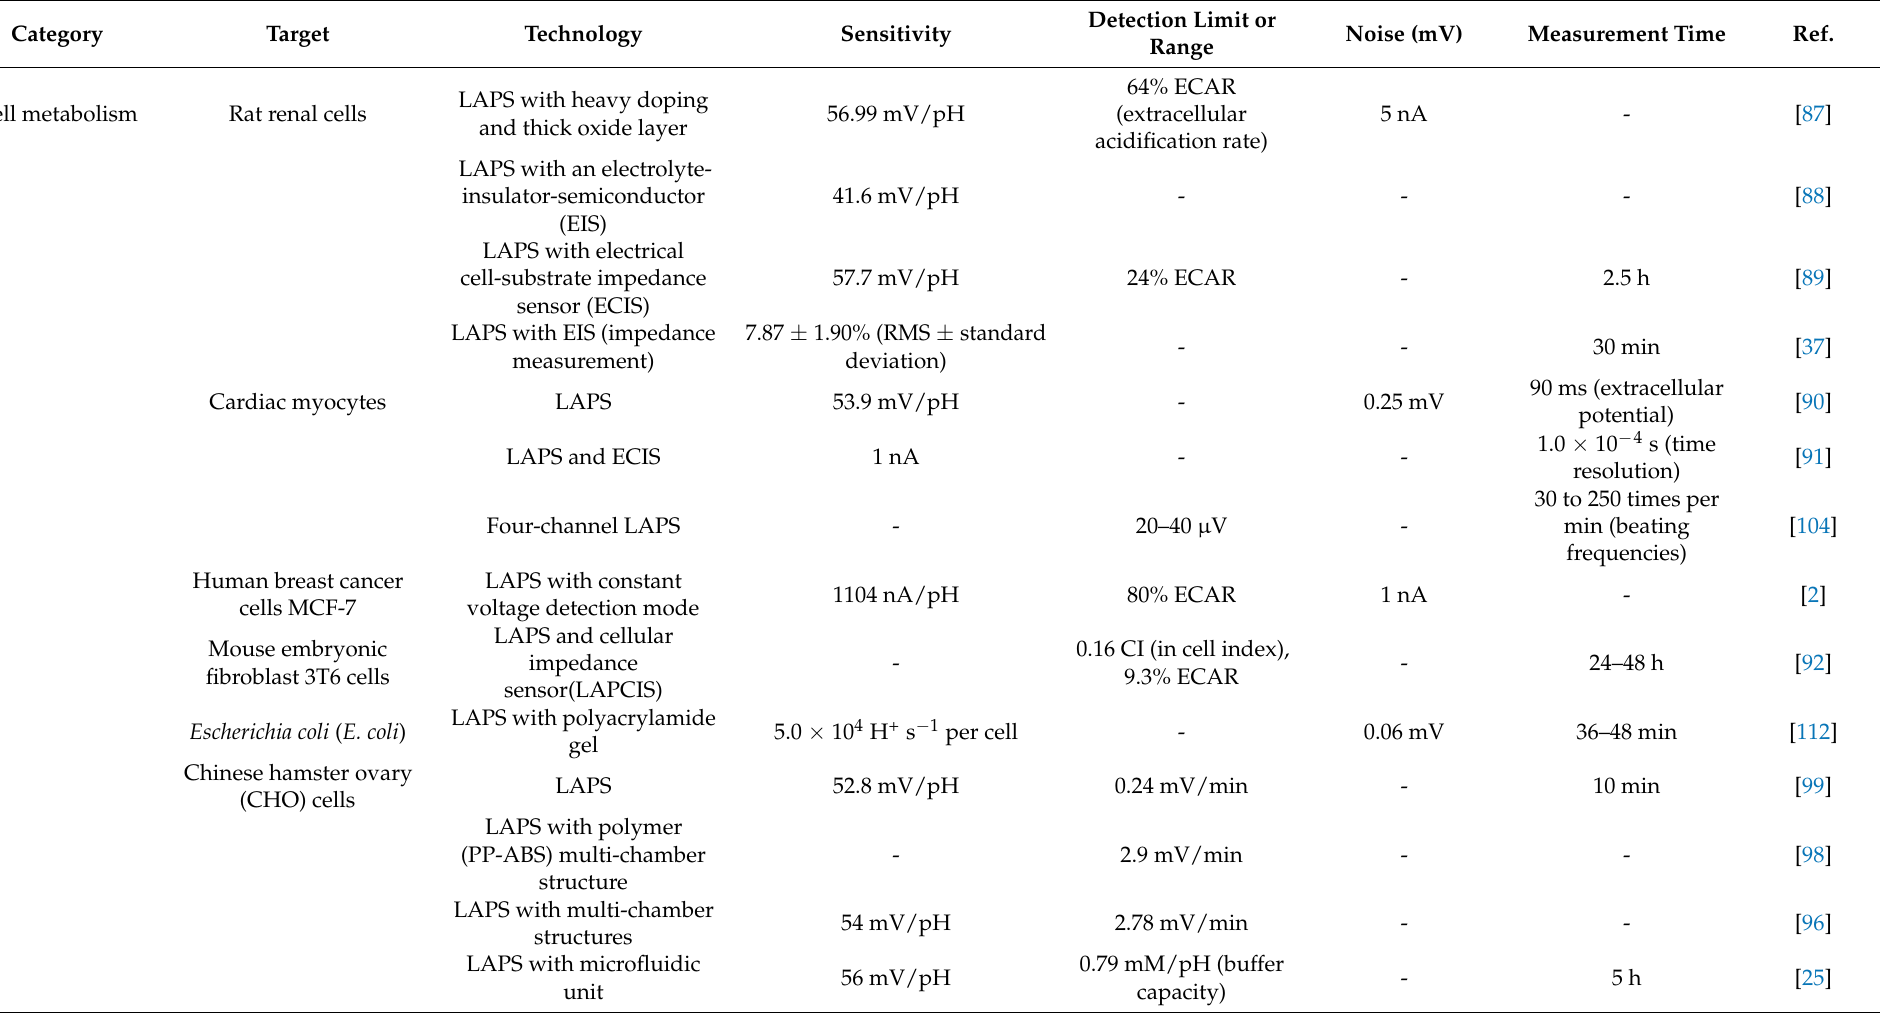
Table 4. Categories, targets, technology, sensitivities, detection limits or ranges, noise and measurement times of articles on LAPS cell monitoring published in recent